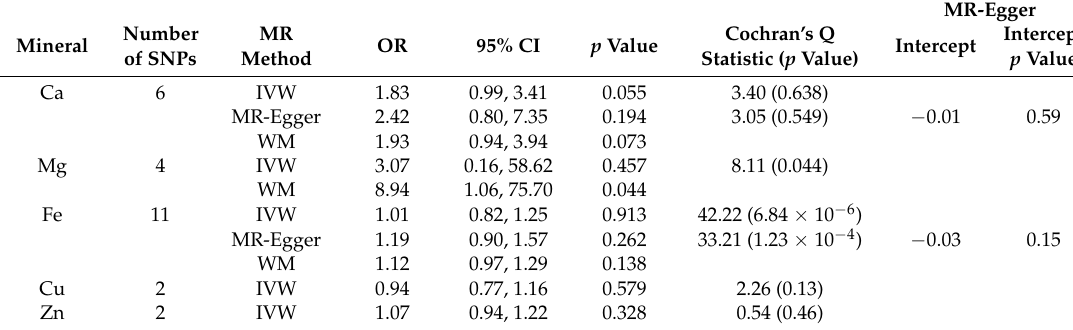
Table 5. MR estimates of the causality between five minerals and